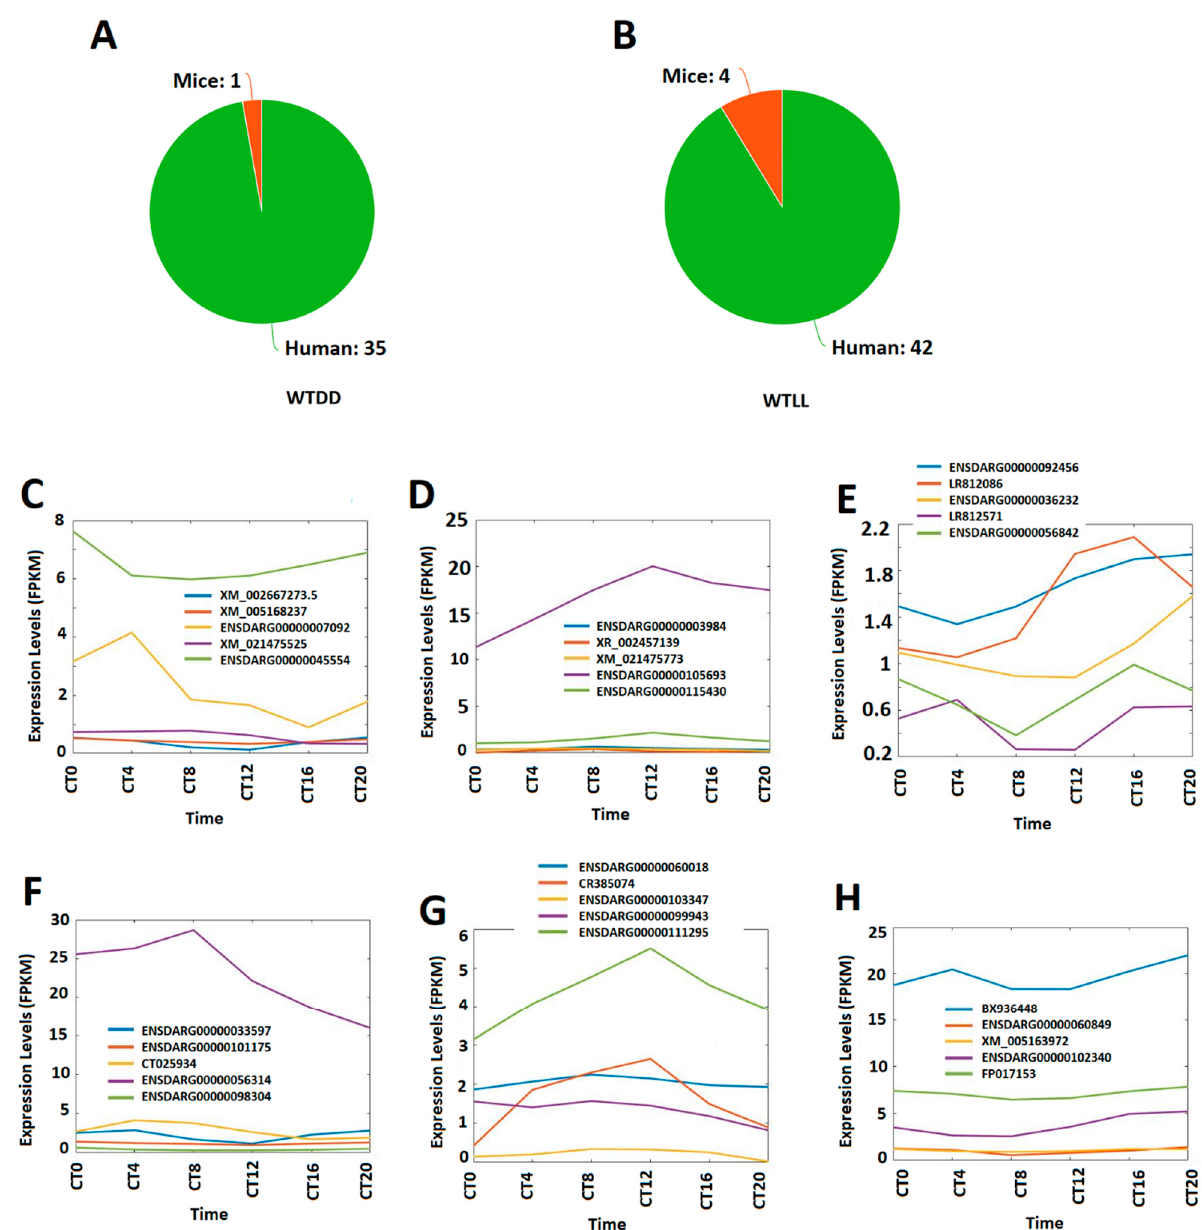
Figure 9. Conservation of circadianly expressed larval lncRNAs in humans and mice, and classification of lncRNAs conserved with humans into the morning, evening, and night groups. The numbers of human and mouse orthologs of the circadianly expressed zebrafish larval lncRNAs under DD condition ( A ) and LL condition ( B ). ( C – E ) Expression profiles of the representative larval morning (CT0 and CT4) lncRNAs ( C ), evening (CT8 and CT12) lncRNAs ( D ), and night (CT16 and CT20) lncRNAs ( E ), under the DD condition, shared with humans. ( F – H ) Expression profiles of the representative larval morning (CT0 and CT4) lncRNAs ( F ), evening (CT 8 and CT12) lncRNAs ( G ), and night (CT16 and CT20) lncRNAs ( H ), under the LL condition, shared with humans.